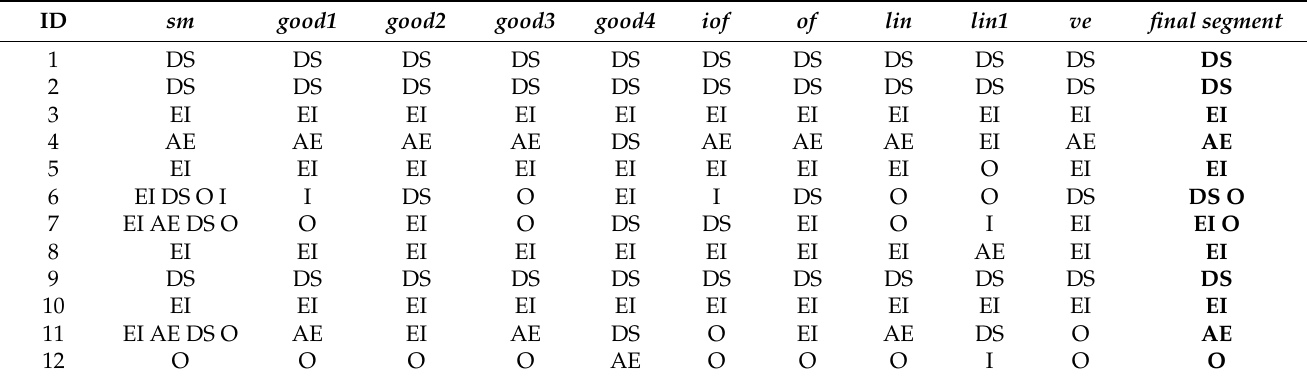
Table 7. Classification results and the final